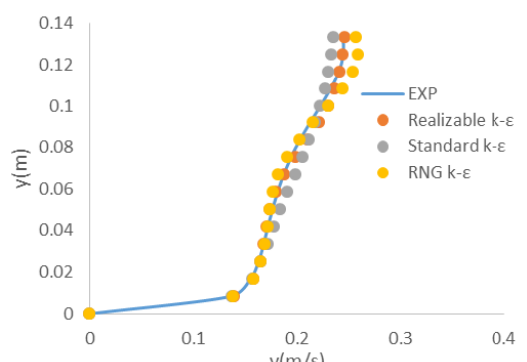
Fig. 4. Comparison of the velocity profile with a variety of k-ε turbulence models and experimental results Table 2. The error rate (RAE %) of k-ε turbulence models